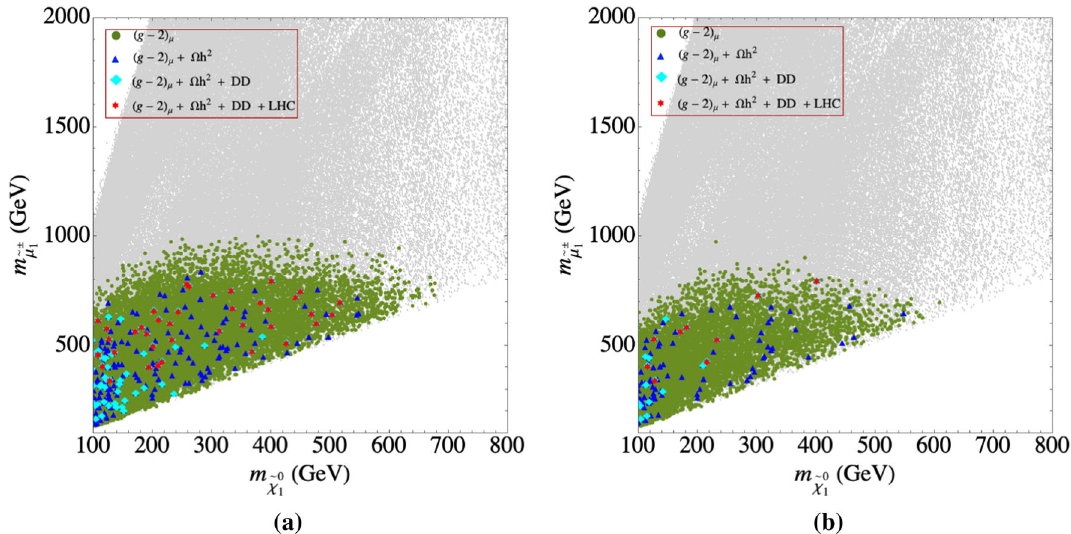
Fig. 12 The results of our parameter scan in the m ˜ χ 0 from ( g − 2 ) μ ). The color coding as in Fig. 11